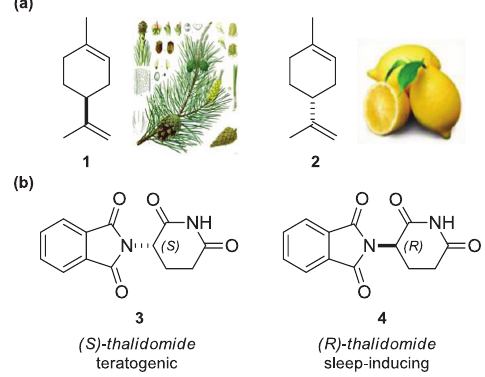
Figure 1. (a) Limonene enantiomers and respective different fragrances: turpentine and lemon; (b) thalidomide, the two